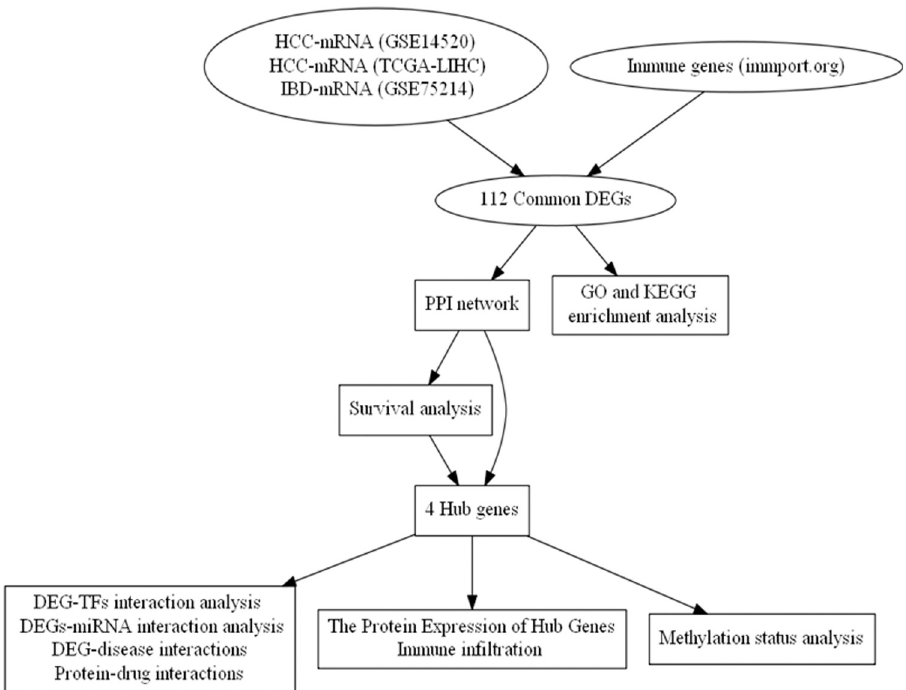
Fig 1. The workflow of the current study. HCC, hepatocellular carcinoma; IBD, inflammatory bowel disorder; DEGs, differentially expressed genes; PPI, protein-protein interaction; GO, gene ontology; KEGG, Kyoto Encyclopedia of Genes and Genomes; TFs, Transcription